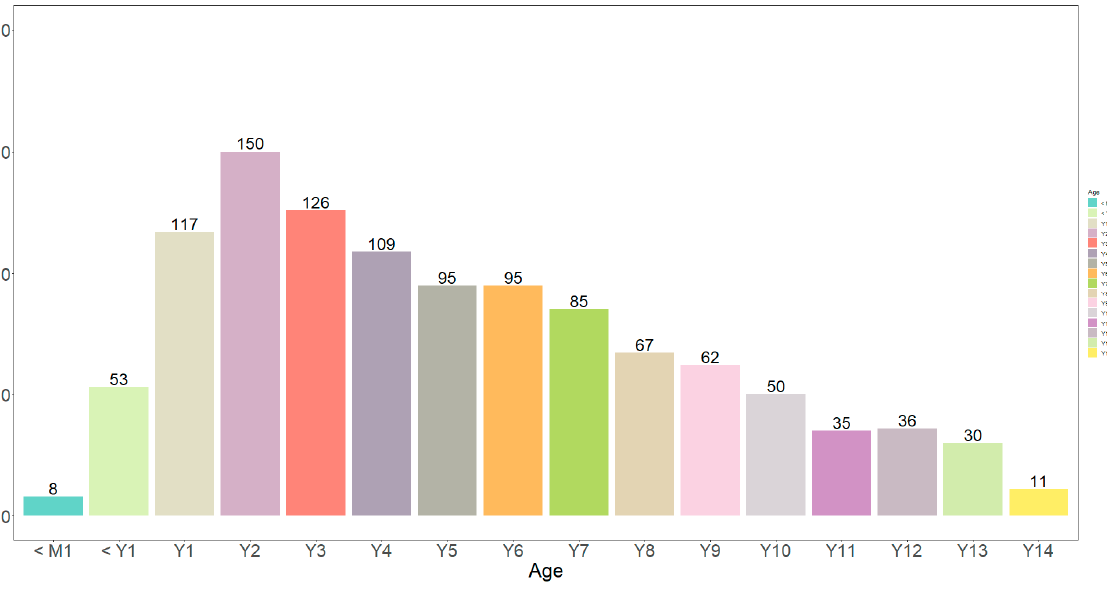
Figure 3. Age distribution of pediatric orthopedics patients from 2006 to 2021.